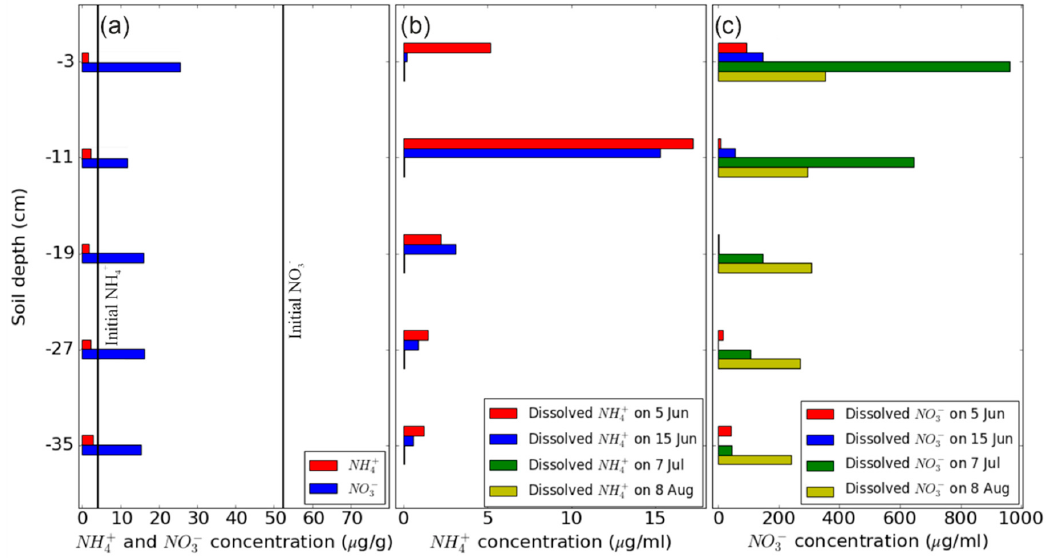
Figure 9. Concentration of mineral N at different depths of the soil column, ( a ) of ammonium (NH 4+ ) and nitrate (NO 3 − ) extracted from soil samples taken after drainage on May 30, ( b ) and ( c ) of NH 4+ and NO 3 − , respectively, in soil solution sampled at the four different time points indicated.